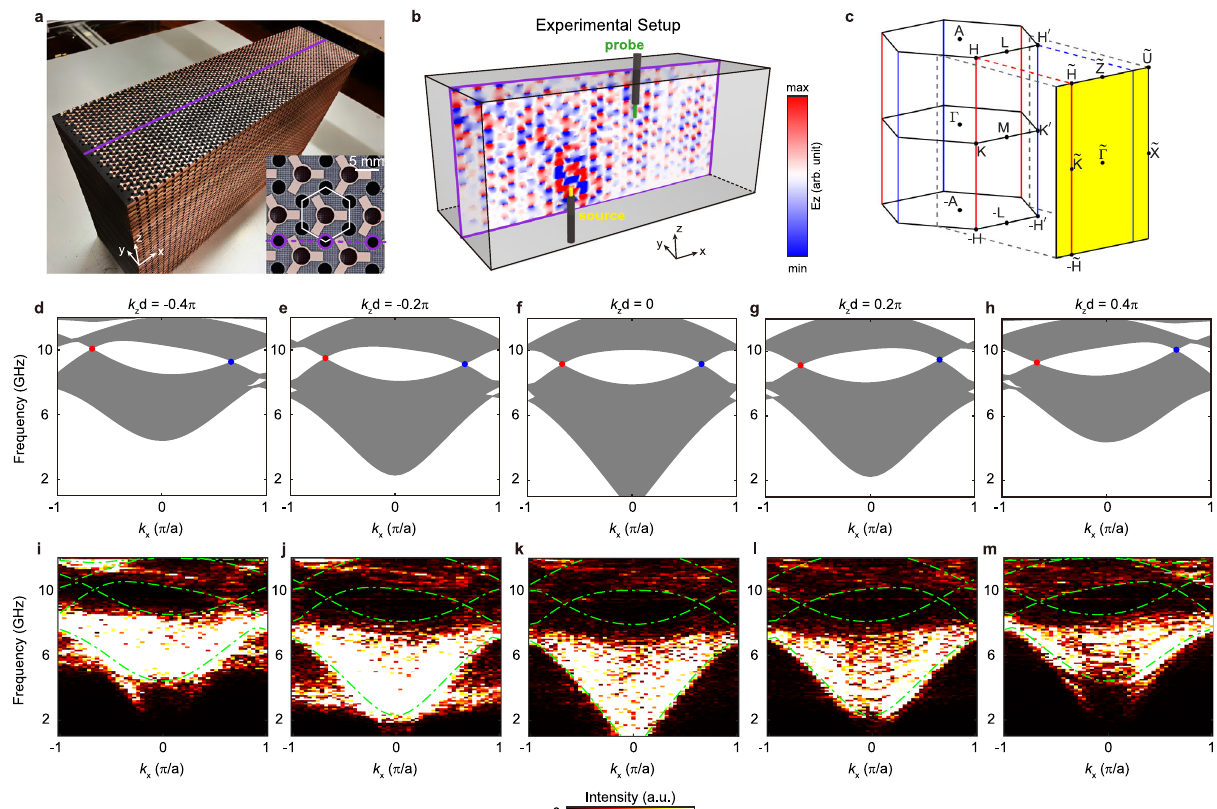
Fig.3 |ExperimentalobservationofbulkANLs.a Photographof thesample.The purplelinedepictsthemeasuredplanetoprobethebulkstates.Inset:enlargedtop view of the structure. Purple circles depict the reserved air holes for probing. b Experimentalsetupforprobingthebulkbandstructure.Adipolesourceantenna (yellow) isinsertedfrom the bottom, whereas the probe antenna(green) scans the middle x – z planehole-by-hole.Anumericallysimulated E z distributionat9.5GHzis plotted at the measured plane. c Bulk Brillouin zone and its surface projection